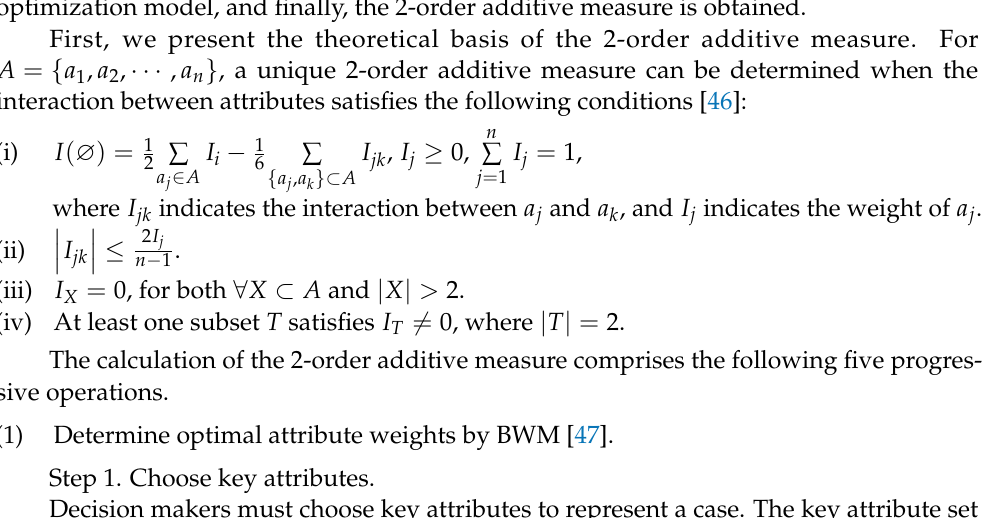
Figure 4. Aeroengine fault semantic graph.